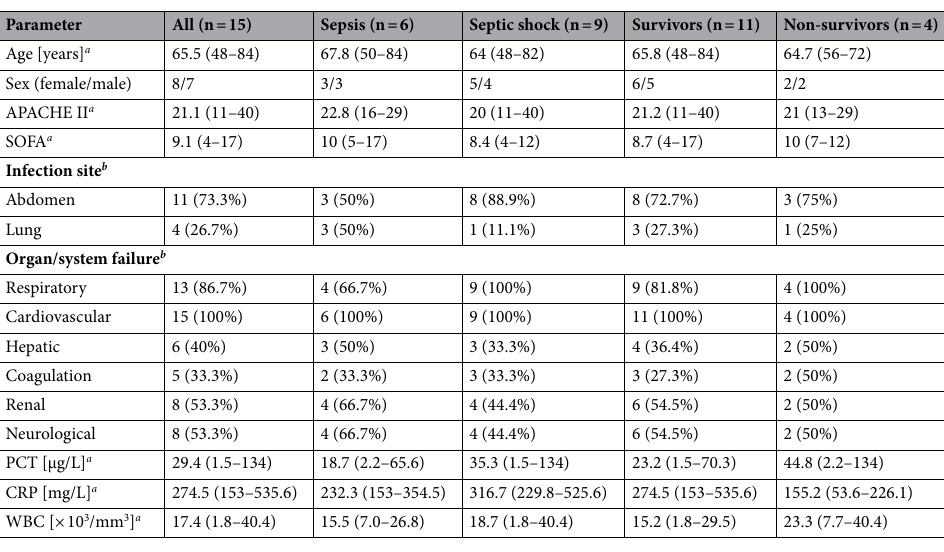
Table 5. Demographic and clinical data on admission to the ICU. Data are expressed as the mean value with range (a) or the actual number of patients (b). APACHE II, Acute physiology and chronic health evaluation II; SOFA, sequential organ failure assessment; PCT, procalcitonin; CRP, C-reactive protein; WBC, white blood cells